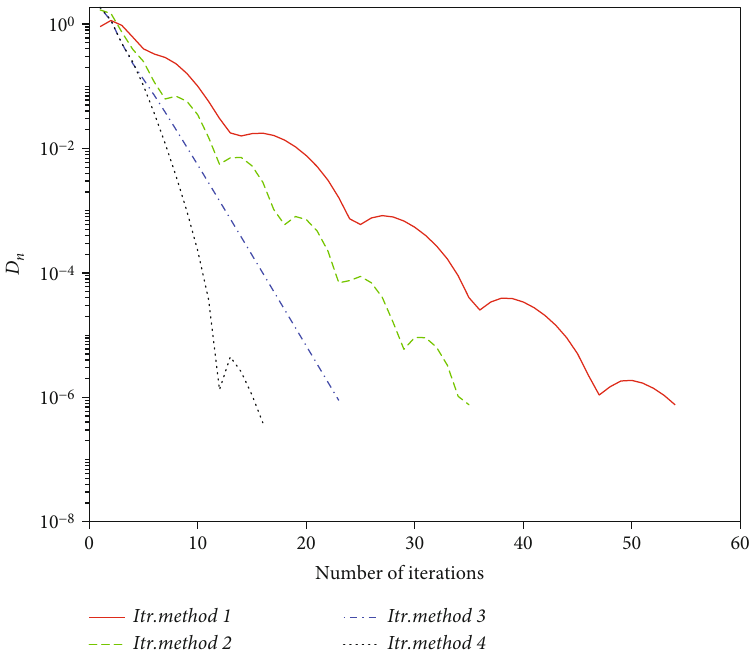
Figure 3: All methods are compared computationally while x